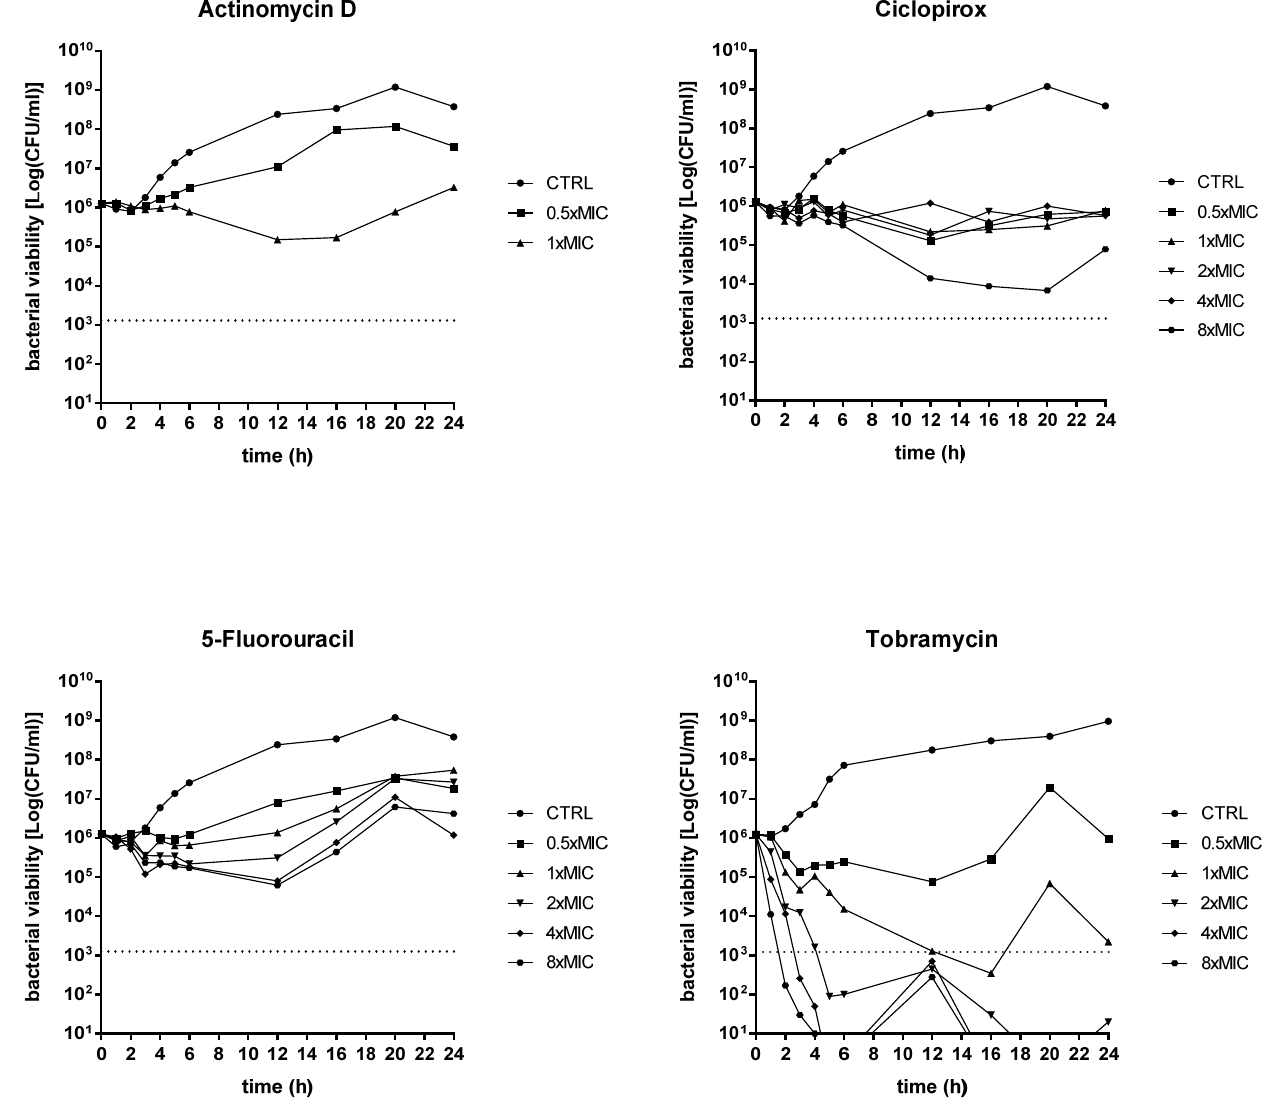
Figure 3. Time–kill kinetics against P. aeruginosa Pa7. The kinetics of repurposed drugs was assessed, comparatively to tobramycin, over 24 h in a liquid medium. P. aeruginosa Pa7 was chosen as repre- sentative of tobramycin-susceptible strains. Each drug was tested at MIC value (actinomycin D: 266 mg/L; ciclopirox: 128 mg/L; 5-fluorouracil: 128 mg/L; tobramycin: 2 mg/L), its fractions and multi- ples, compatibly with the drugs’ solubility. The dotted line indicates bactericidal activity, defined as a ≥ 3 Log (CFU/mL) reduction of the initial inoculum size. The limit of detection was 10 CFU/mL. An evident dose-dependent activity was observed only in the case of actinomycin D, 5-fluorouracil was evaluated using a checkerboard assay. P. aeruginosa Pa7 and PaPh32 although with different effects depending on the strain tested. It always had a bacterio- static result towards the Pa7 strain, whereas it yielded a bactericidal effect—i.e., greater than 3 Log-fold decrease in CFUs, equivalent to 99.9% killing of the inoculum, was ob- served—towards the PaPh32 strain when tested at 1x (after 11 h of exposure) and 2xMIC value of 0.56 for tobramycin + ciclopirox combination against Pa7 (after 8 h of exposure). Actinomycin D caused a viability decrease of PaPh32 below the limit of detection (LOD) when tested at 1x (after 14 h of incubation) and 2xMIC (after 11 h of incubation), while a regrowth was found at 1xMIC. A similar trend was observed for ciclopirox that exerted bactericidal activity only when tested towards the PaPh32 strain after 7 h exposure at 4xMIC. The worst activity was shown by 5-fluorouracil, yielding a